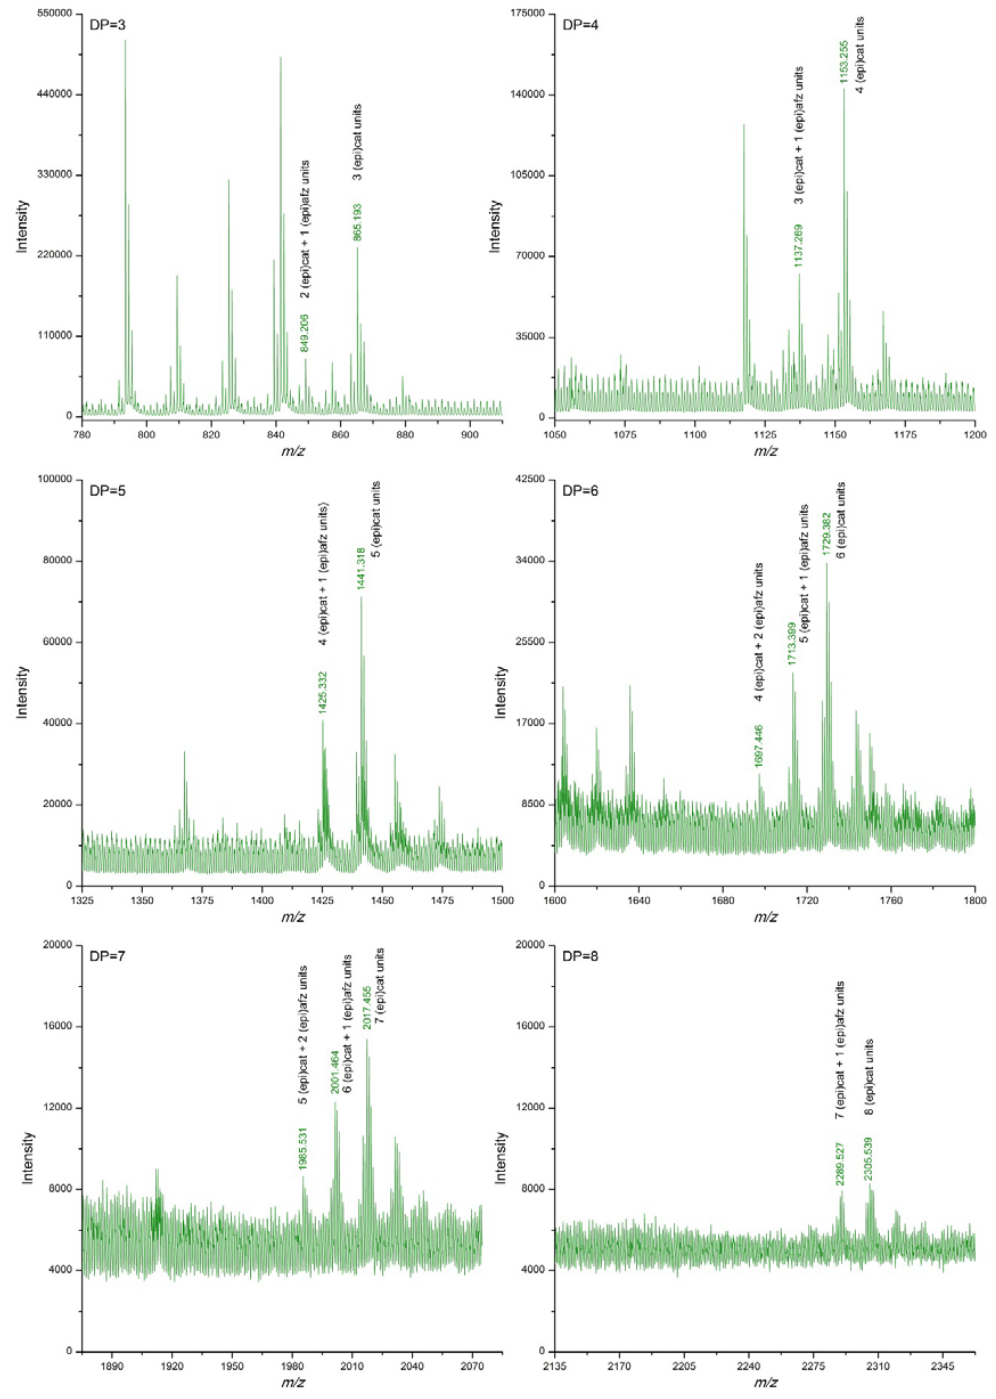
Figure 5. Enlargements of DI-ESI-QTOF mass spectrum of proanthocyanidins with DP 3–8 from a sample of U. tomentosa wood from Sarapiquí location.